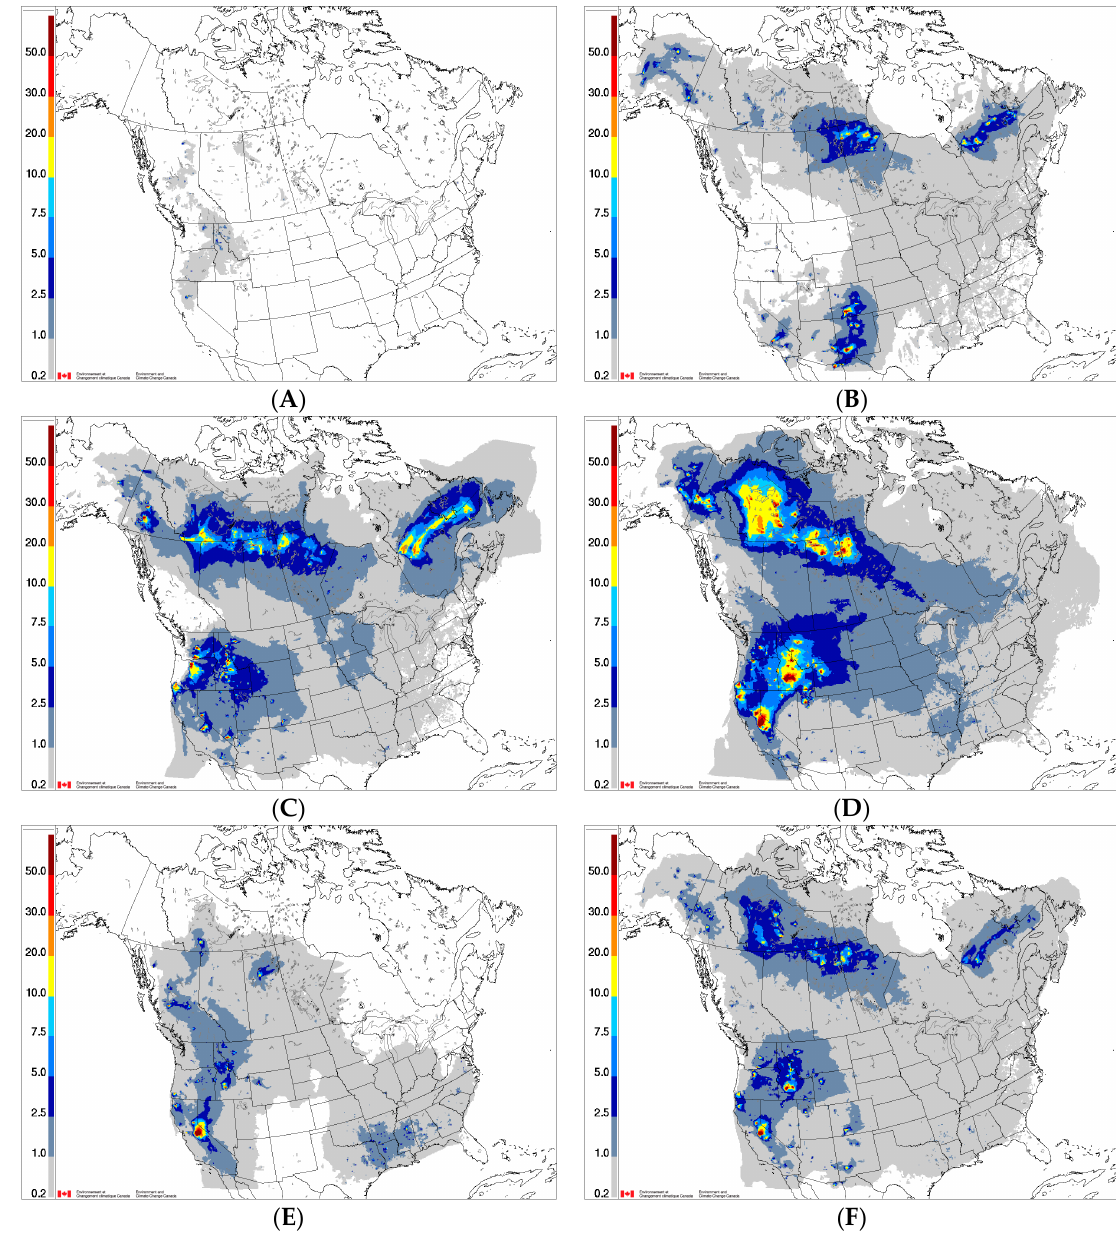
Figure 3. 2013 average monthly fire-PM 2.5 contribution to total forecasted surface PM 2.5 concentrations (µg/m 3 ) for ( A ) May, ( B ) June, ( C ) July, ( D ) August, ( E ) September, and ( F ) seasonal (May–September average). Note that the color scale is non-linear and white areas indicate values < 0.2 µg/m 3 .